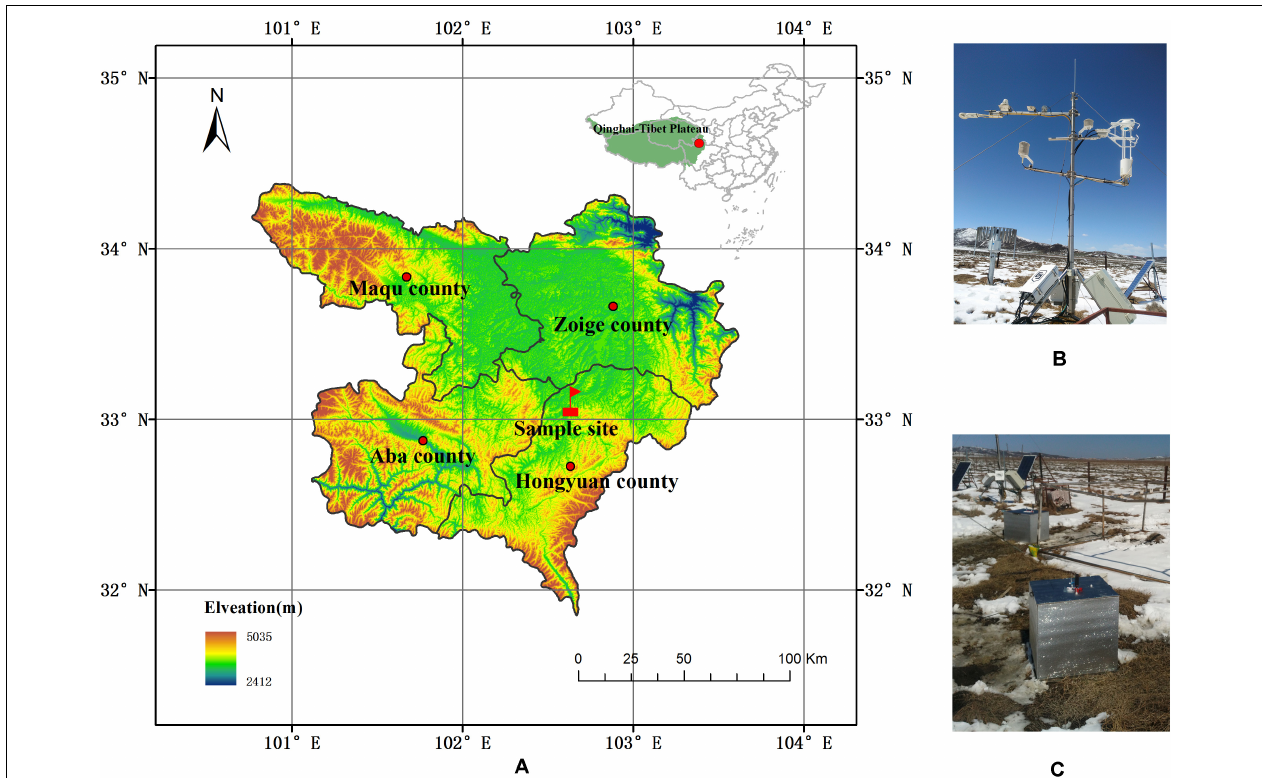
FIGURE 1 | Location of the Riganqiao Provincial Wetland Reserve. (A) Elevation map showing the sample site, denoted with a red flag, located on the Qinghai-Tibetan Plateau in the northeast region of Hongyuan county, China. Photographs of the (B) eddy covariance system and (C) static chamber used in this